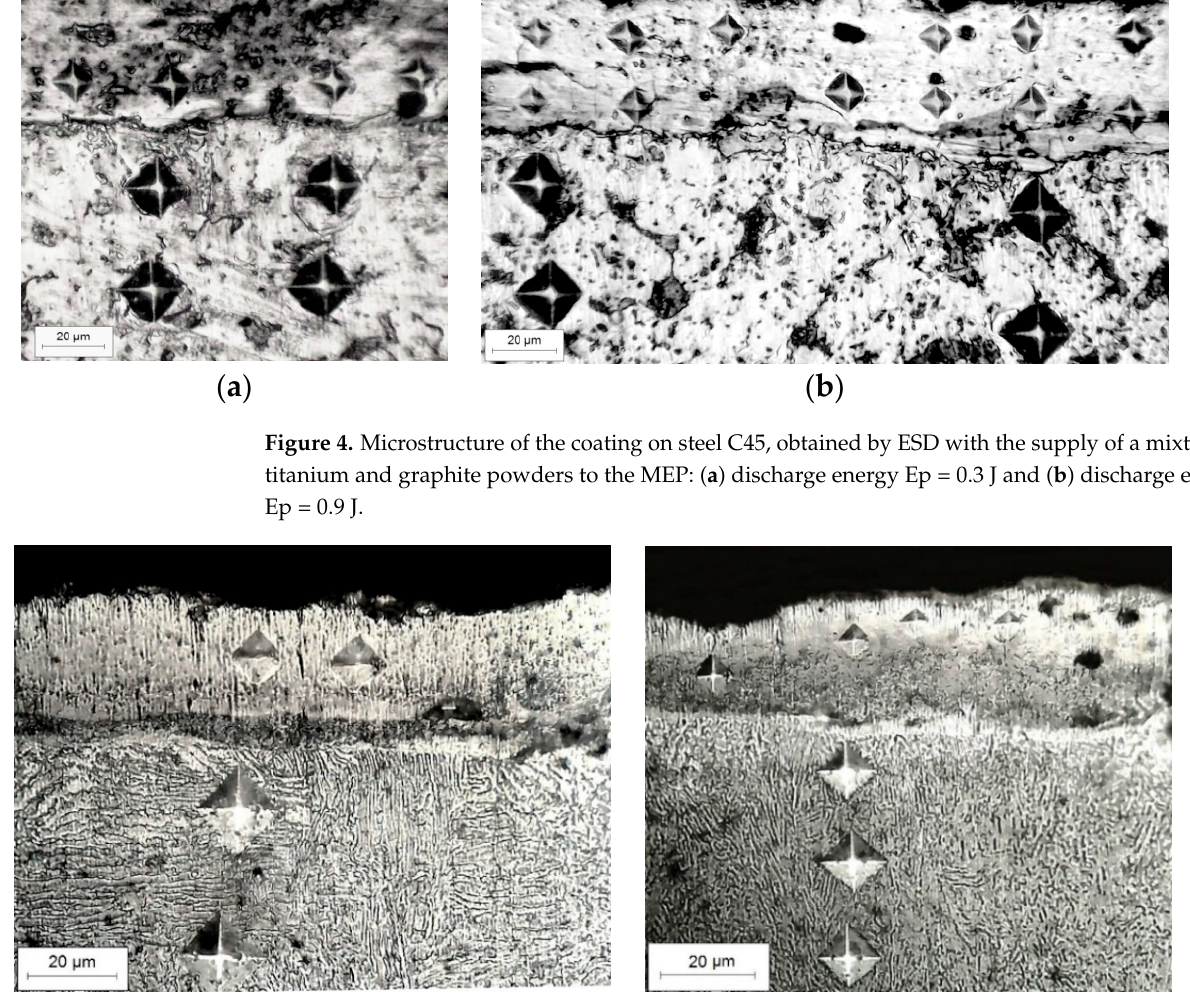
Figure 5. Microstructure of titanium alloy OT4 subjected to ESD with a mixture of powders of tungsten and graphite ( a ), and molybdenum and graphite ( b ).